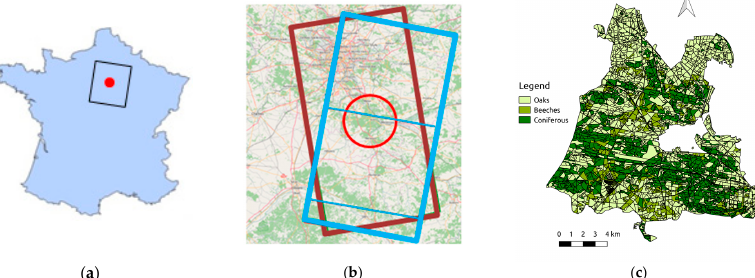
Figure 1. ( a ) Overall location of Fontainebleau area in France with the coverage resulting from Sentinel-1 descending orbit; ( b ) zoom in on the Fontainebleau Forest with the coverages from ascending (brown rectangle) and descending (blue rectangle) Sentinel-1 acquisitions (relative orbits no. 59 and 110, respectively); ( c ) inventory of tree species in the Forest’s stands. Colors indicate the dominant species.